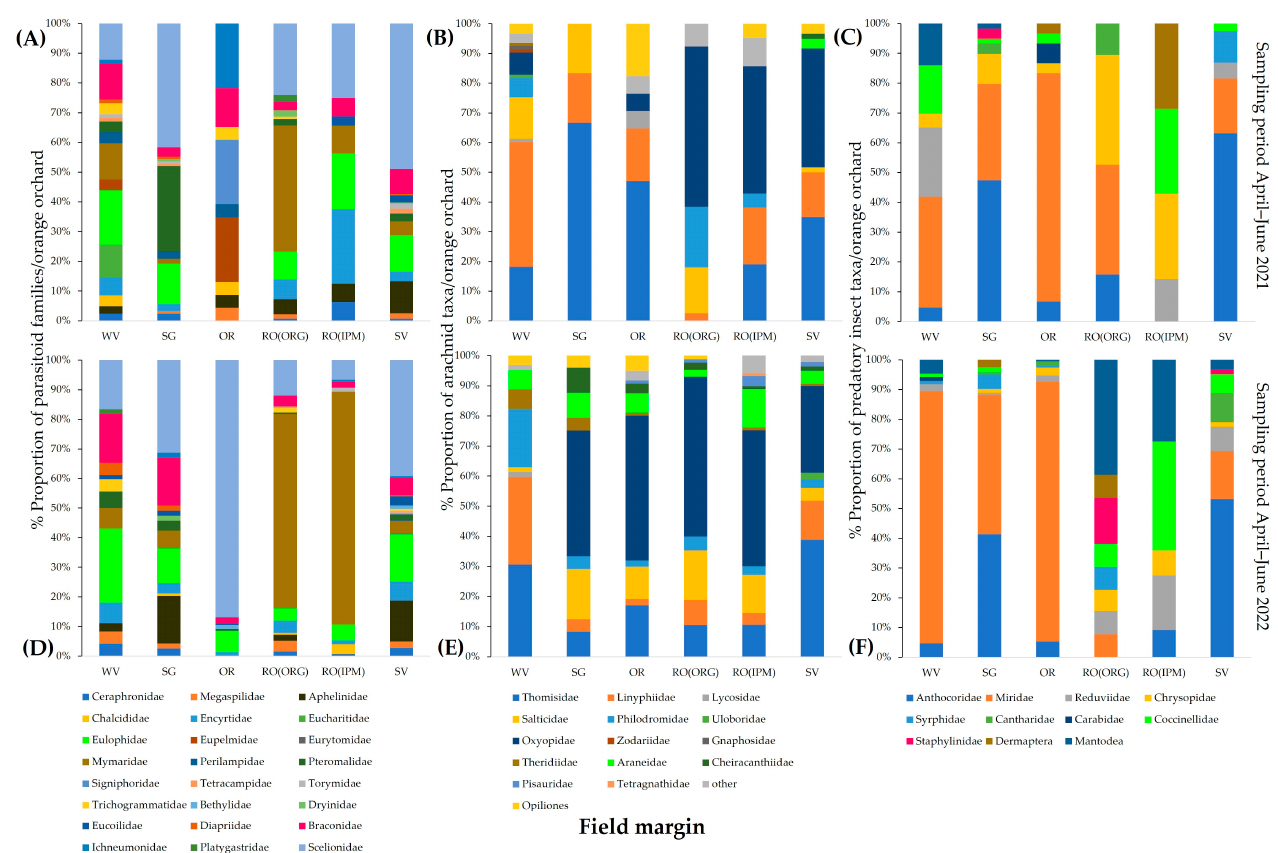
Figure 9. Community composition of natural enemies in fi eld margins of orange orchards with dif- ferent fi eld margin management. Sampling period April–June 2021: ( A ) Hymenoptera parasitoids; ( B ) arachnid predators; ( C ) insect predators. Sampling period April–June 2022: ( D )